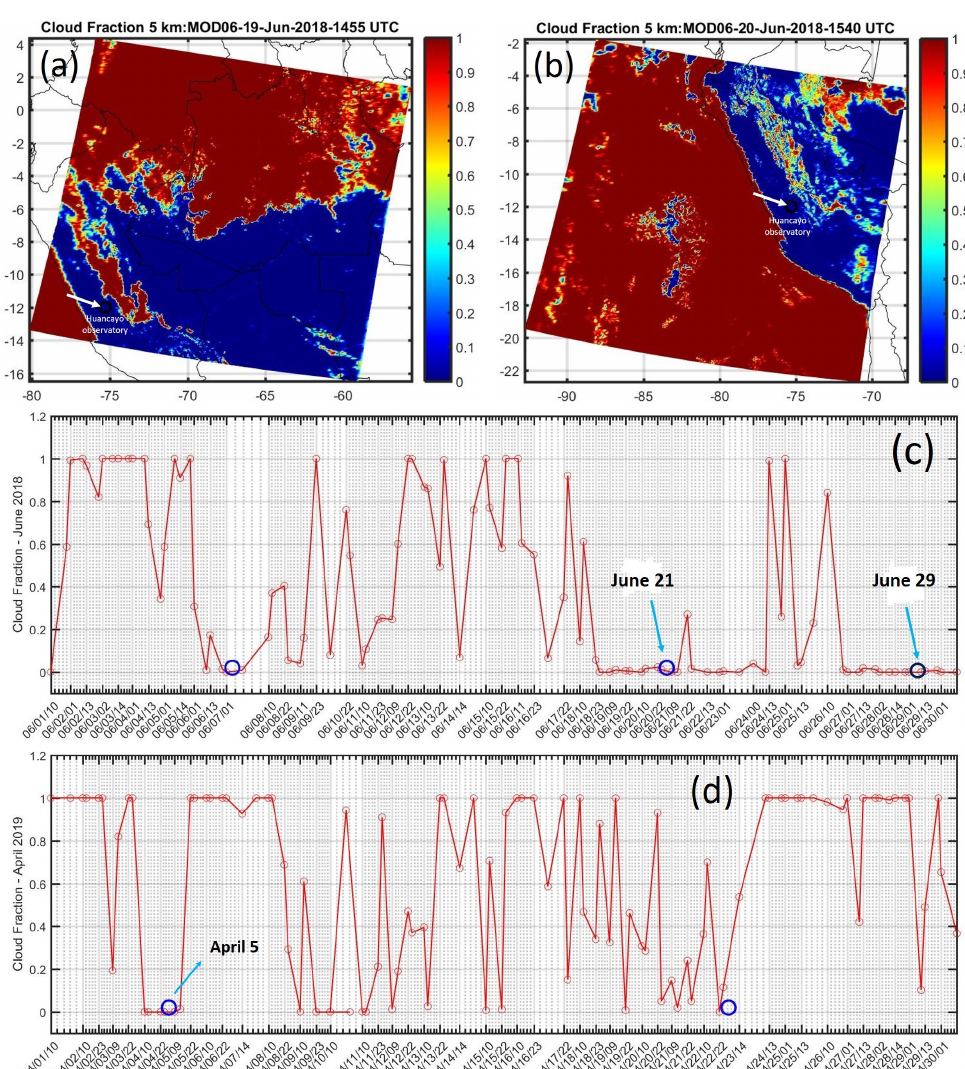
Figure 10. ( a ) Spatial distribution of cloud fraction obtained by MODIS sensor onboard of Terra satellite above the HYO for 19 January 2018 at 1455 UTC (955 LT). ( b ) Spatial distribution of cloud fraction obtained by MODIS sensor onboard of Terra satellite above the HYO for 20 January 2018 at 1540 UTC (1040 LT). One indicates completely overcast sky and zero indicates complete clear sky conditions. Longitudes, latitudes and geopolitical contours are indicated. Time series of cloud fraction obtained by MODIS sensor above the location of the HYO during ( c ) June 2018 and ( d ) April 2019. During diurnal hours on 21 June 2018, maximum Q ∗ reached values close to 520.4 W m − 2 around noon, which was higher than the mean monthly values in June (495.2 W m − 2 around noon). In contrast, the standard deviation values of Q ∗ were signifi- cantly lower than the mean monthly values, which was an indication of the prevalent clear sky conditions on 21 June. In contrast, maximum Q H was 278.1 W m − 2 at around 14 LT, which was slightly lower than the mean monthly values of Q H in June (309.2 W m − 2 at 14 LT). The same occurred for Q E with maximum values of 34.49 W m − 2 at around 14 LT, which was lower than the mean monthly values of Q E in June (74.86 W m − 2 ). Finally, maxi- mum Q G value was 220.6 W m − 2 at 10 LT, which was higher than the mean monthly values in June (181.5 W m − 2 at 10 LT). In general, the standard deviations of all energy balance components on 21 June 2018 were significantly lower than the mean monthly